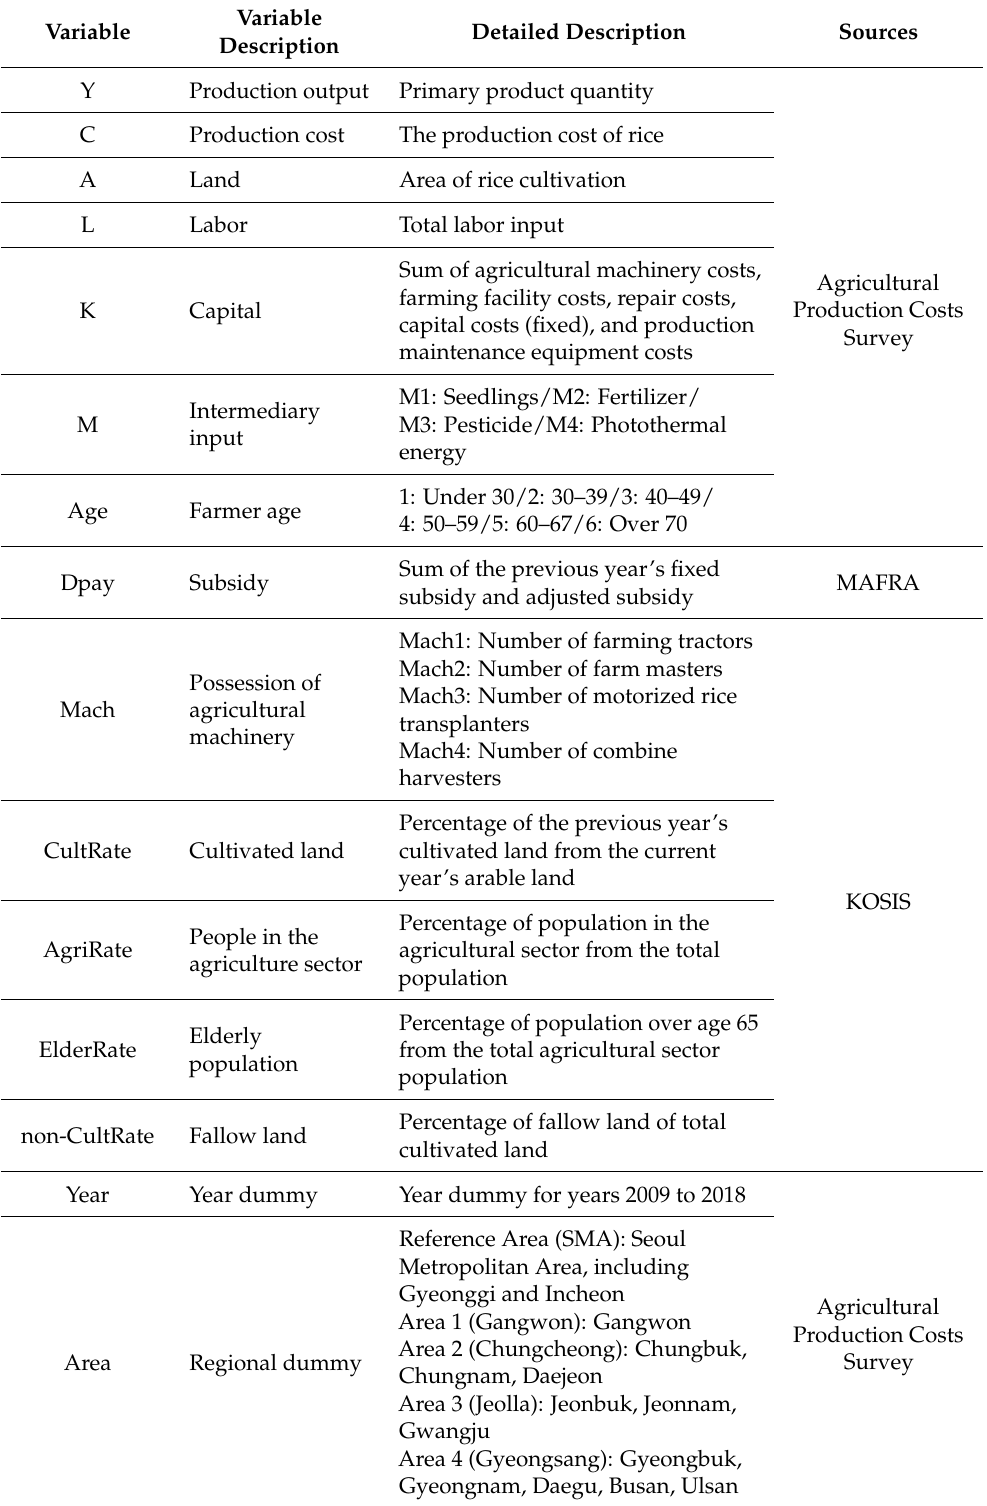
Table 1. Description of variables used in agricultural output and costs